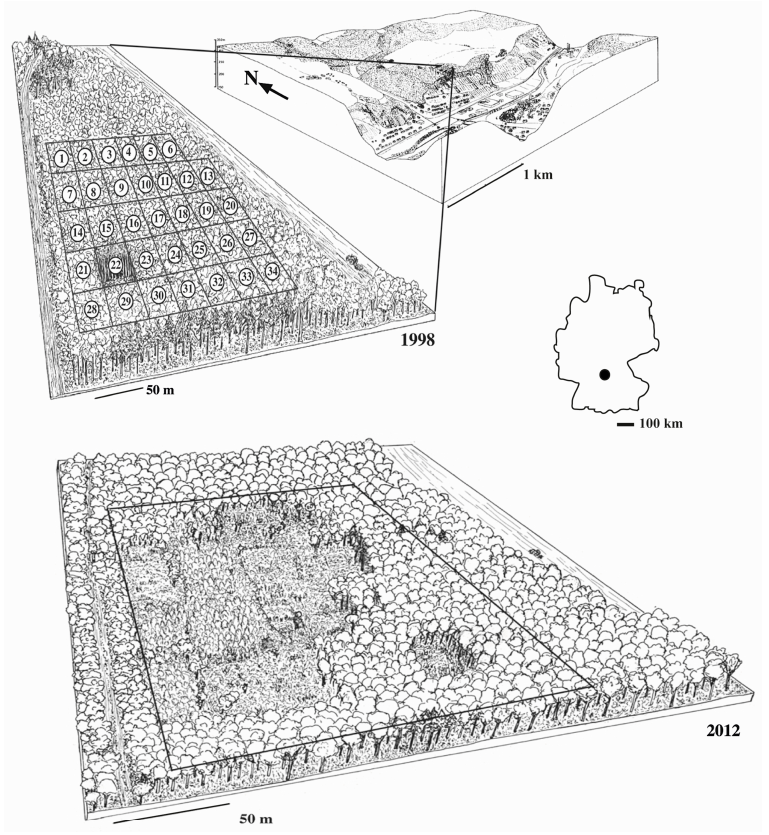
Figure 1. The regional setting of the experimental field in 1998 and